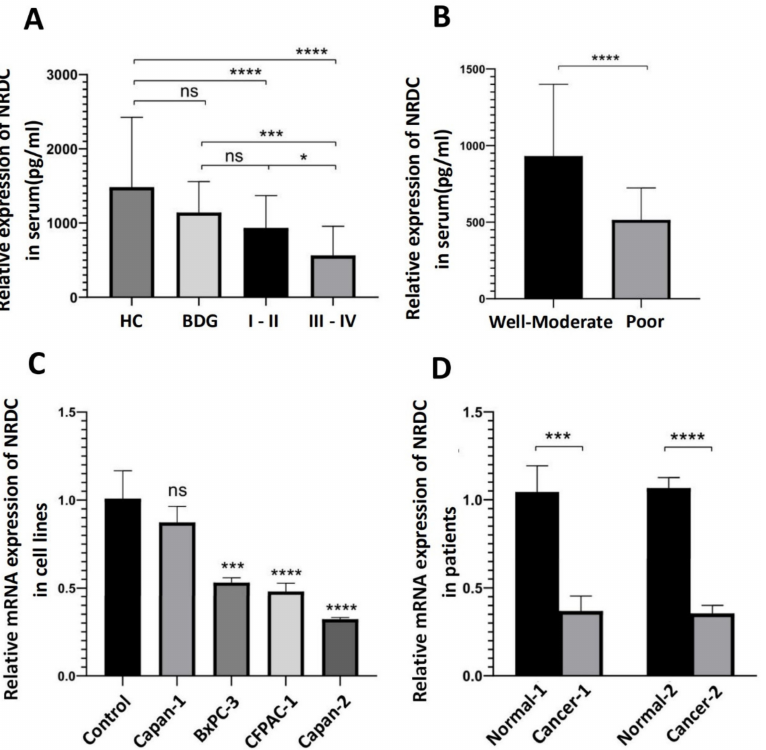
Figure 1. The expression levels of NRDC. ( A ) Serum NRDC levels in control group and PDAC different staging groups. HC ( n = 61), BDG ( n = 31), and PDAC including I/II ( n = 63), III/IV ( n = 48). ( B ) Serum NRDC levels in various differentiation groups, well-moderated group ( n = 58), poor differentiation group ( n = 25). ( C ) Relative mRNA expression levels in cell lines, all PDAC cell lines were compared to the normal pancreatic cell lines. The procedure was repeated three times, consistent with the previous results. ( D ) Relative mRNA expression levels in two patients, Cancer-1/2 were from two different patients’ cancer tissues, Normal-1/2 were from patients’ peritumoral tissues. The procedure was repeated three times in six patients’ tissues, consistent with the previous results. * p < 0.05, *** p < 0.001, and **** p < 0.0001. ns: none significance, HC: healthy control, BDG: benign disease